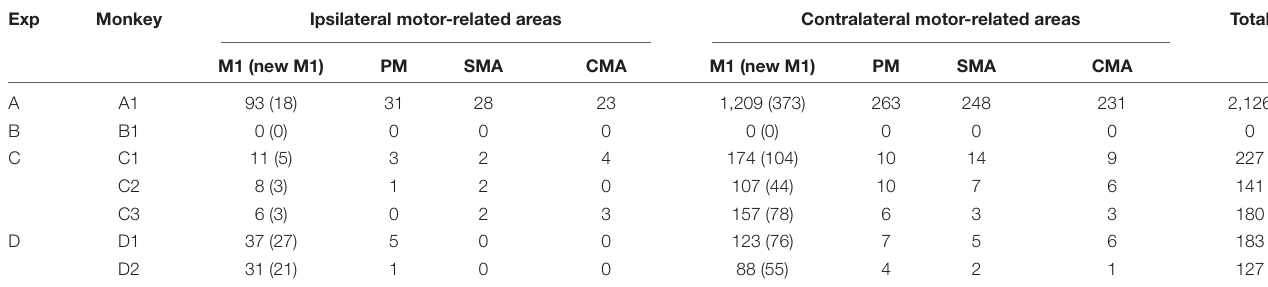
TABLE 1 | Number of cortical neurons projecting to spinal forelimb segments (C6–T1). Exp Monkey Ipsilateral motor-related areas Contralateral motor-related areas